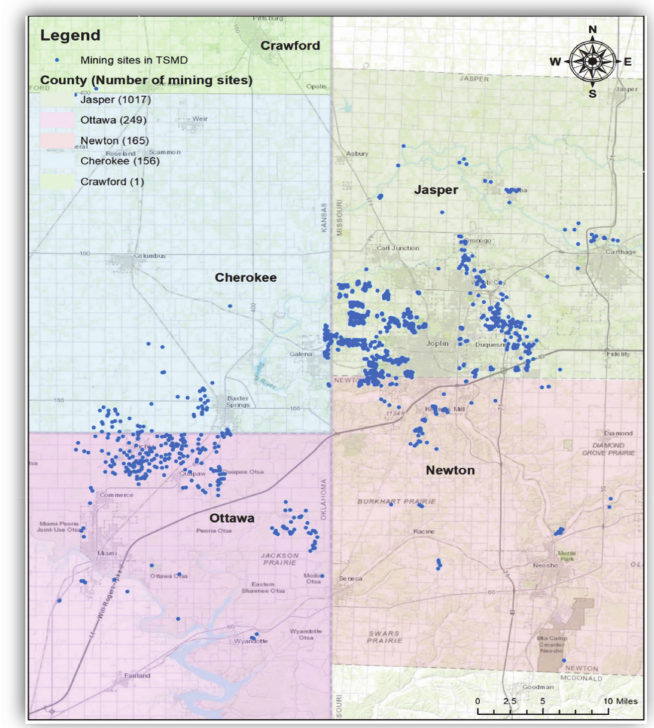
Figure 2. Locations of TSMD Superfund Sites. Note: Blue indicates the mine-related sites in the TSMD. There were 1017 sites in Jasper County, Missouri, 249 sites in Ottawa County, Oklahoma, 165 sites in Newton County, Missouri, and 156 sites in Cherokee County, Kansas. The geospatial database was obtained from the U.S. Geological Survey (USGS) (Date taken: 29 July 2020). The USGS data